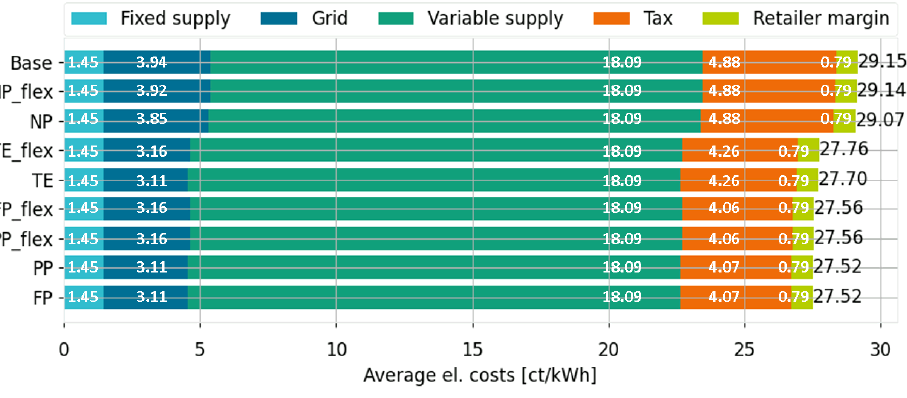
Figure 7. Cost of energy consumption for consumers under various use cases of prosumership. Values are calculated based on the annual costs for the different price components divided by the total annual energy